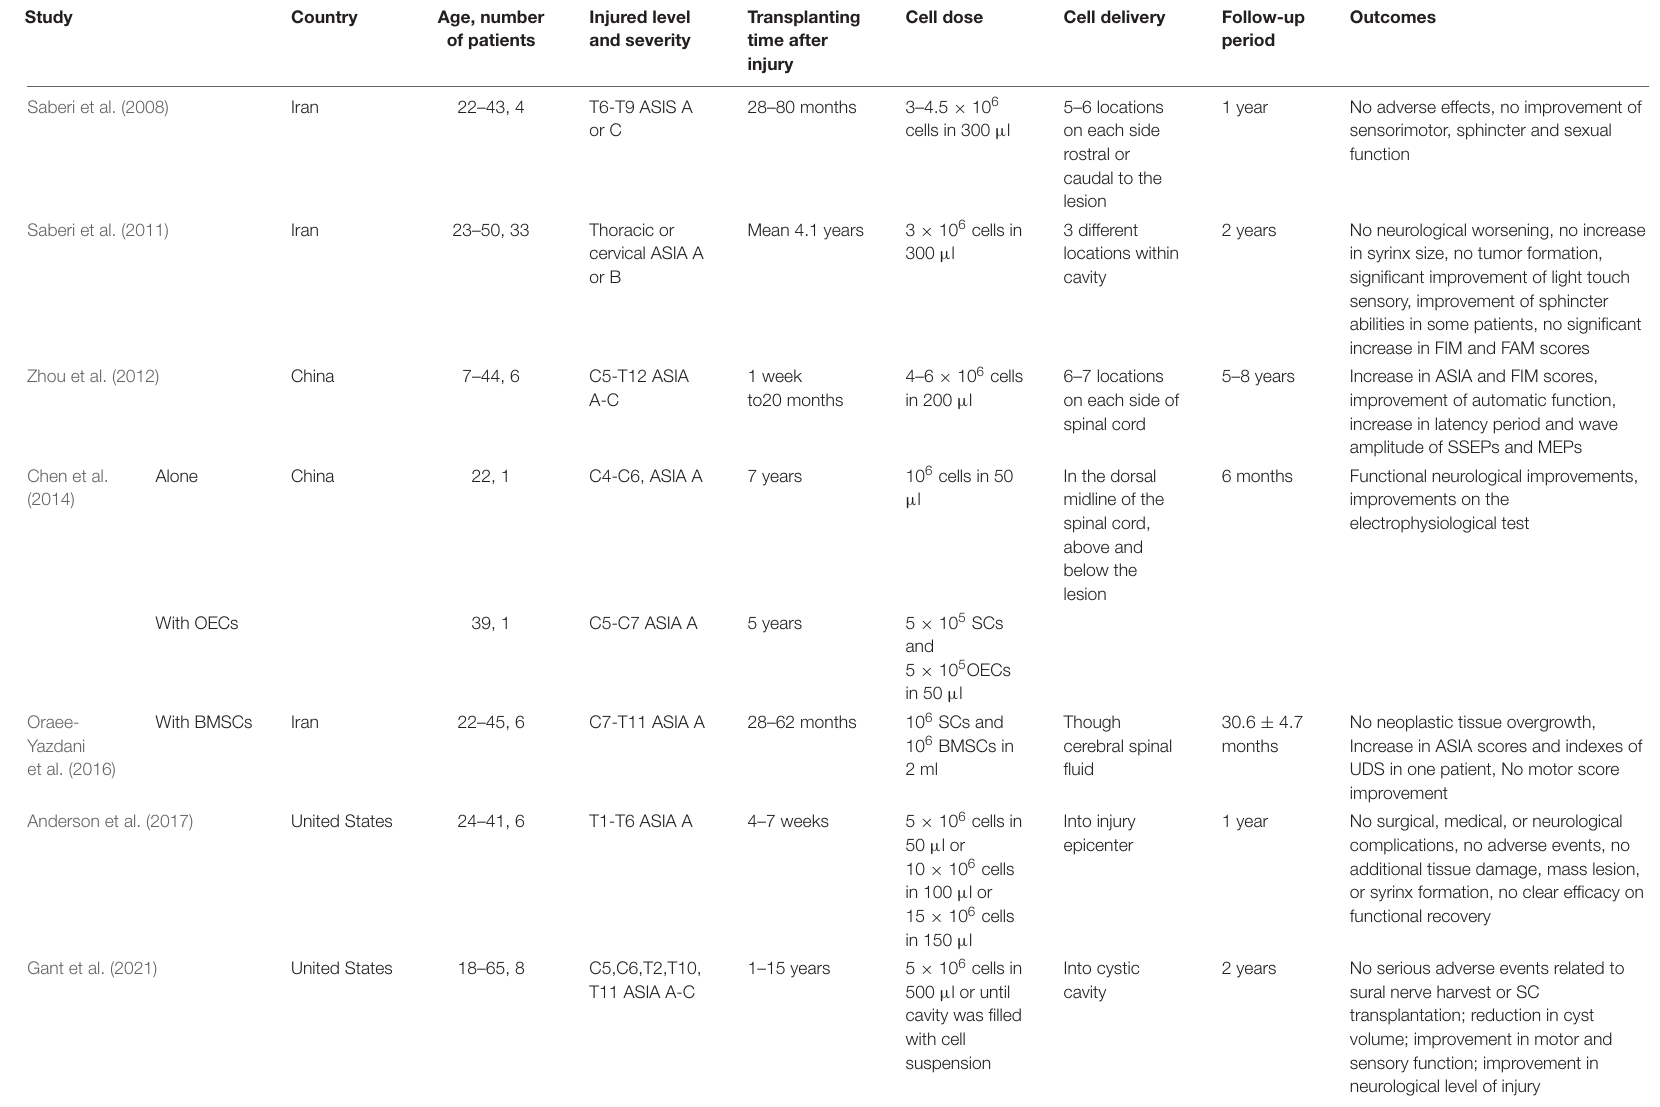
TABLE 1 | Clinical trials of Schwann cell transplantation (alone or together with other cell types) for spinal cord injury.